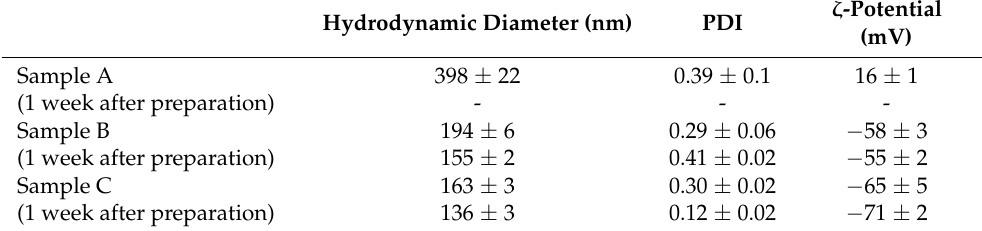
Figure 3. Scattered light intensity vs. hydrodynamic diameter curves measured for the samples A, B and C immediately after sonication (solid lines) and after one week (dashed lines). Table 3. Results of the DLS and ζ -potential measurements for the three kinds of samples. The hydrodynamic diameter (nm), the PDI and the ζ -potential (mV) are reported. For the bare NPs one week after preparation DLS measurements could not be performed. For the other samples. The concentration of the dispersions was ca. 0.02 mg/mL for all samples and the pH 6.5. Temperature 298 K.